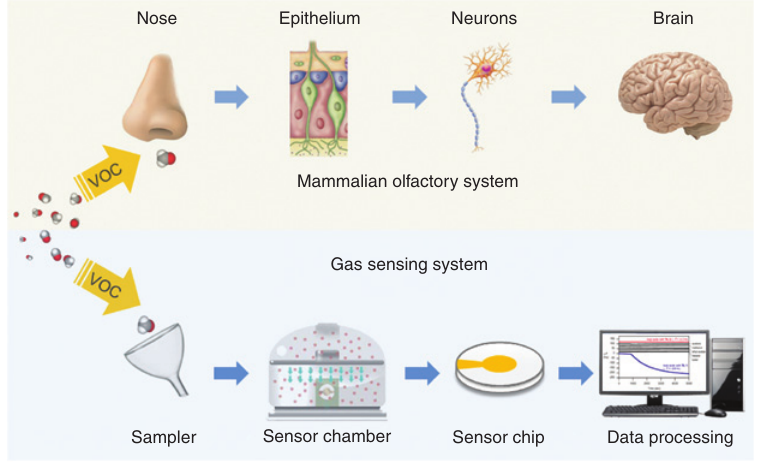
Figure 1: Schematic comparison of mammalian olfactory system and the QCM gas sensing